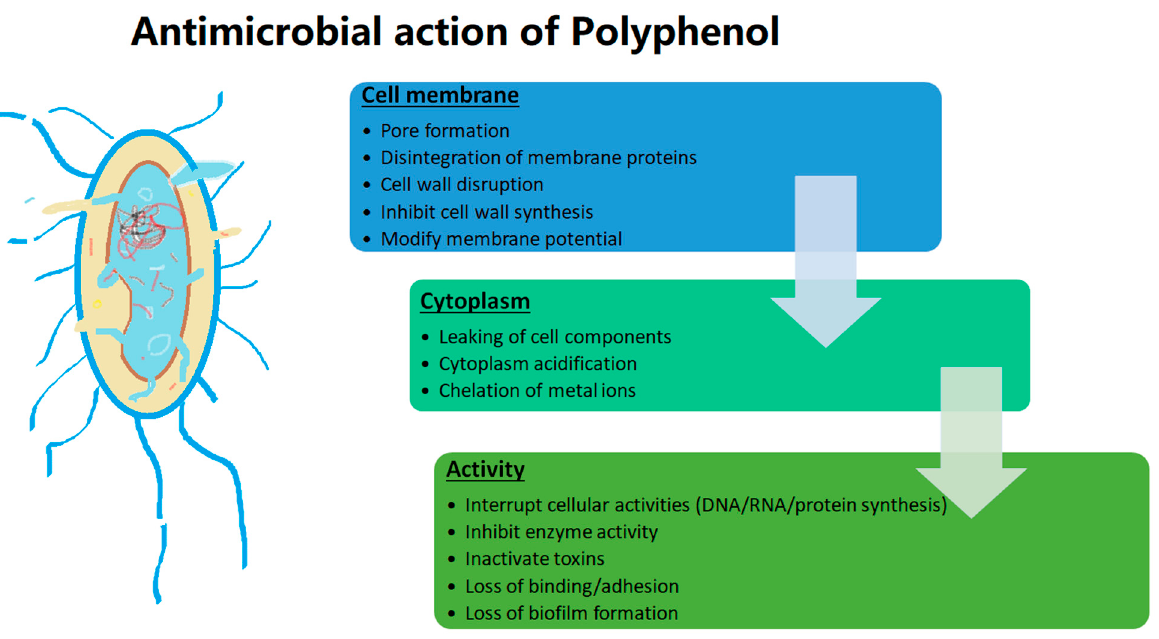
Figure 4. Antimicrobial activity of polyphenol.